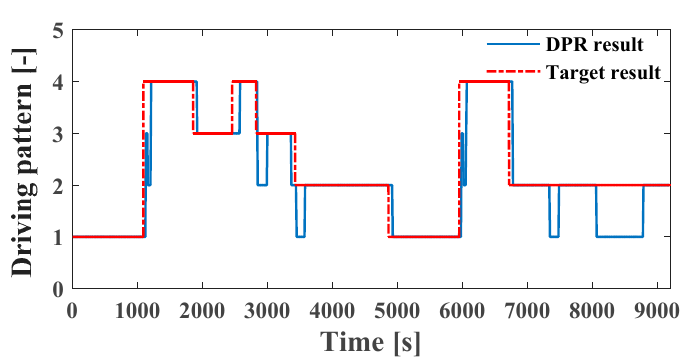
Figure 4. Velocity profile of the test cycle.